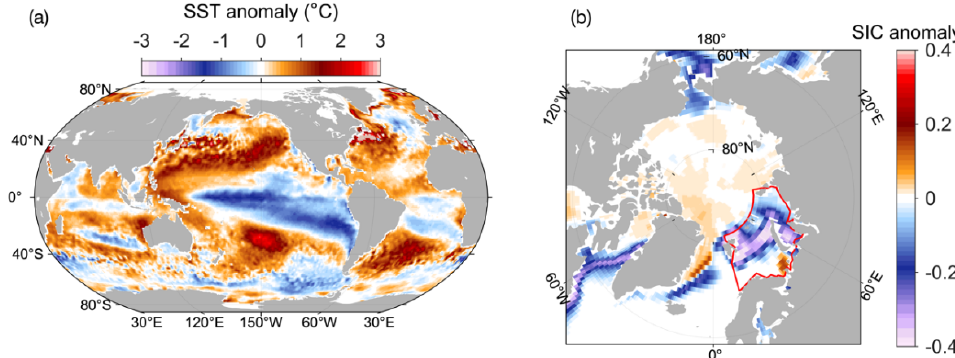
Figure 2. The seasonal means of the anomalous SST and SIC in 2020/2021 winter: ( a ) SST; ( b ) SIC. The irregular red-line box in ( b ) marks the BKS.